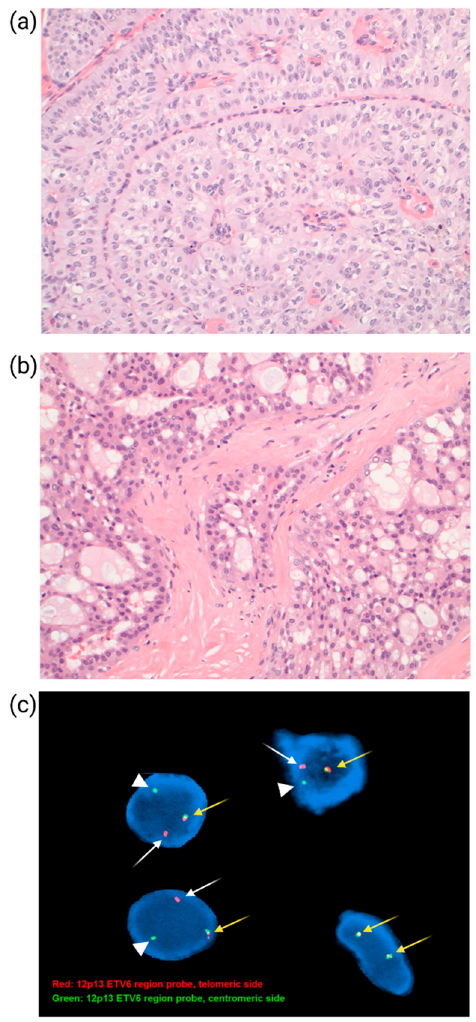
Figure 5. Breast carcinoma with specific features. ( a ) Tall Cell Carcinoma with Reverse Polarity with circumscribed nests of epithelial cells showing a solid papillary pattern and reverse polarity of nuclei located at the apical side of the tumor cells. ( b ) Secretory carcinoma with nests of tumor cells with ample cytoplasm and intracytoplasmic vacuoles. ( c ) ETV6-NTRK3 gene fusion in the case of secretory carcinoma. Dual-color break-apart FISH studies of the tumor cells were performed with a 12p13 ETV6 telomeric probe (red) and a 12p13 ETV6 centromeric probe (green). Single red (arrow) and separate single green (arrowhead) signals demonstrate an ETV6 chromosomal rearrangement. An unsplit red and green probe signal demonstrates a non-rearranged wild-type ETV6 locus (yellow arrow).